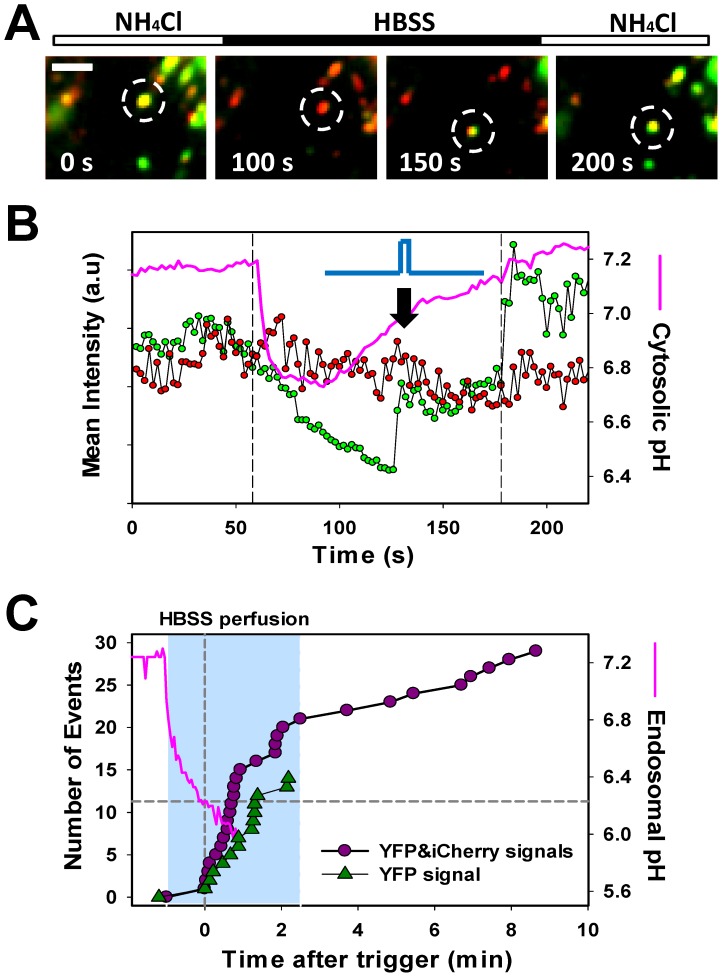
Synchronized ASLV-A Env-mediated fusion of immature HIV-1 particles can be detected by YFP dequenching.(A, B) Time-lapse images of single ASLV-A pseudovirus fusion manifested in YFP dequenching without loss of iCherry (marked by a dashed circle, see also movie S5). Scale bar is 7 µm. (B) Mean fluorescence intensity traces of YFP-Vpr (green circles) and Gag-iCherry (red circles) obtained by tacking the particle shown in panel A. Accompanying changes in the cytosolic pH are shown by a pink line. Vertical dashed lines indicate the onset and the end of HBSS perfusion. The blue trace schematically illustrates the predicted profile of a fusion pore. (C) The rates of synchronized single ASLV-A pseudovirus fusion triggered by removal of NH4Cl (the HBSS perfusion interval corresponds to the blue strip on the graph). The endosomal pH is shown by a pink line, and the time when the pH reaches a threshold value of 6.3 (dashed lines) and designated t = 0. Dark pink circles show the distribution of waiting times to single fusion events following the acidification of endosomal compartments below pH 6.3, as measured by simultaneous loss of the iCherry and recovery of the YFP signal. The rate of fusion events exhibiting YFP dequenching without loss of iCherry is shown by green triangles.